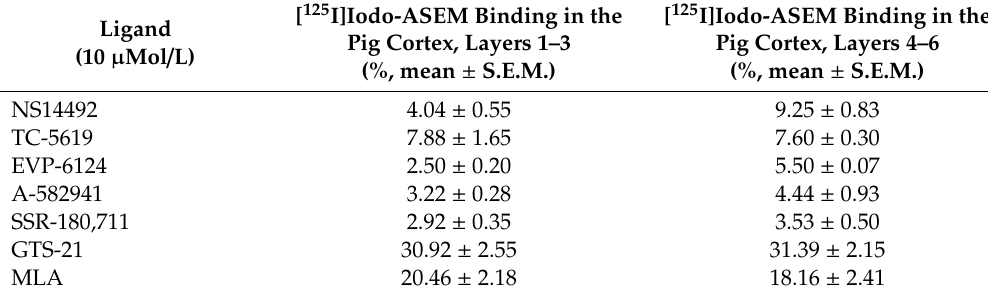
Table 2. Blocking of [ 125 I]Iodo-ASEM binding in the pig cortex by a series of α 7 nAChR ligands. Ligand